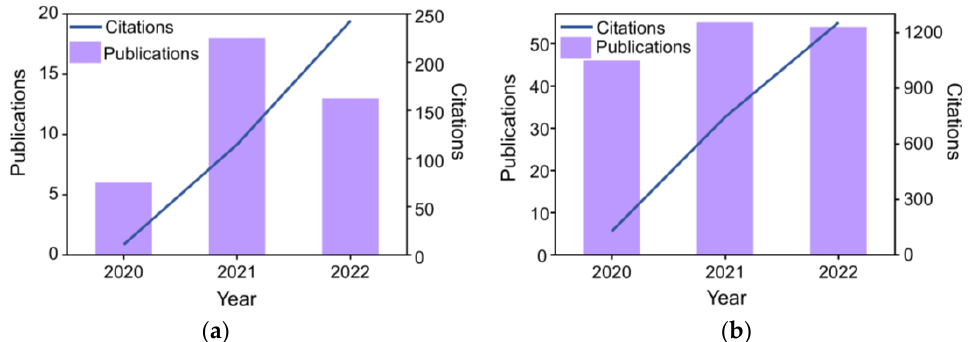
Figure 1. Citation frequency and publication distribution by year for hydrogel-based thermal energy harvesting ( a ) and sensing ( b ).